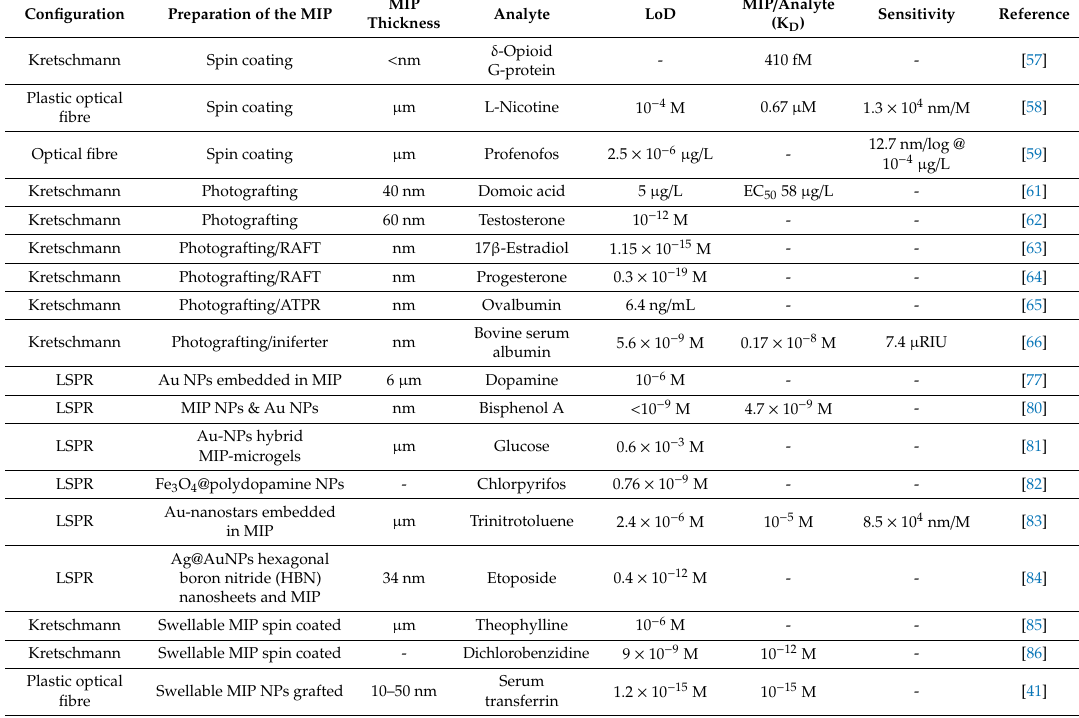
Table 1. Summary and comparison of SPR-MIP sensors from Sections 4.1.1, 4.1.2 and 4.1.5 classified on the basis of the MIP